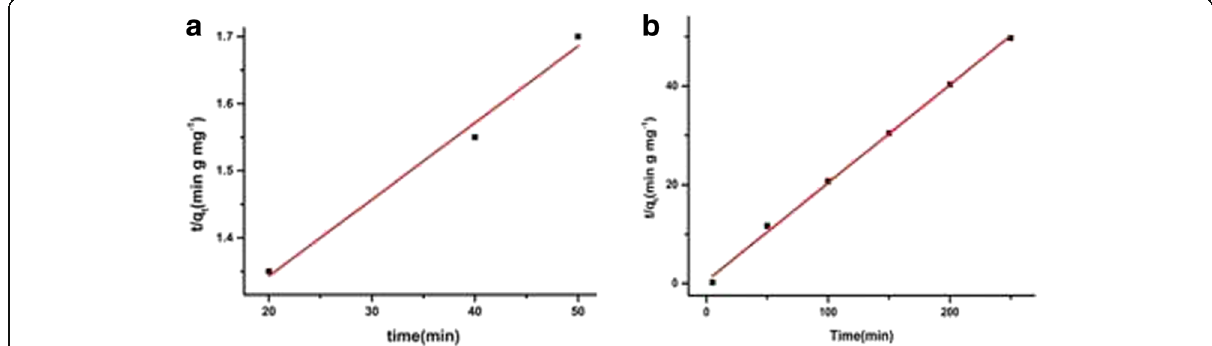
Fig. 7 ( a , b ) Pseudo-second order kinetic model for MB and aniline adsorption on sorbent